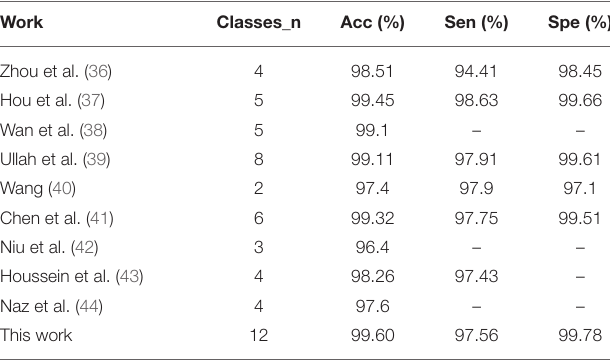
TABLE 4 | The performance of our proposed method compared with previous